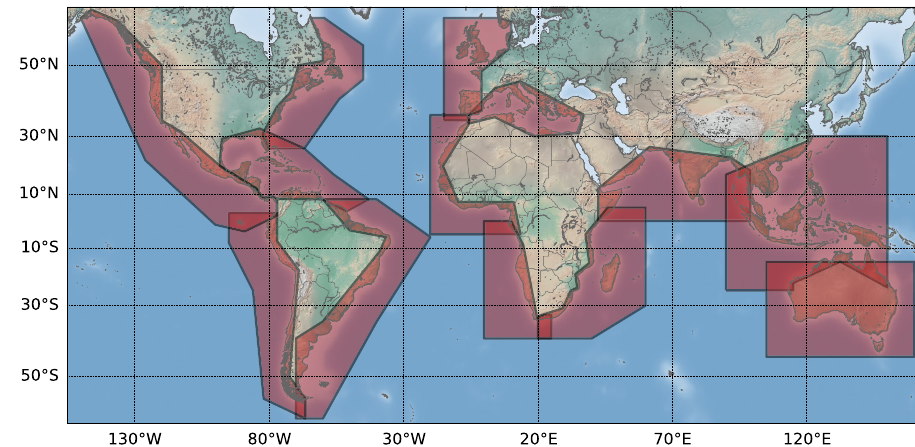
Fig. 1 Map of the studied coastal regions. Polygons (in red) represent the areas where the satellite data reprocessing has been